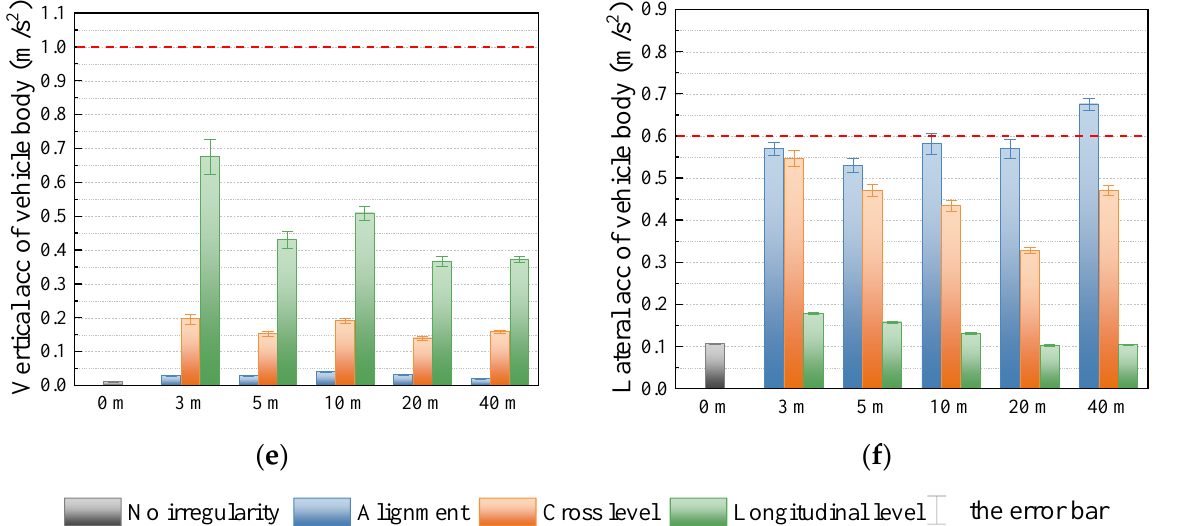
Figure 11. The effects of different irregularities in front of turnout on the maximum value of dynamic indicators at different wavelengths: ( a ) Wheel-rail vertical force; ( b ) Wheelset lateral force; ( c ) Derailment coefficient; ( d ) Wheel unloading rate; ( e ) Vertical acceleration of the vehicle body; ( f ) Lateral acceleration of the vehicle body.